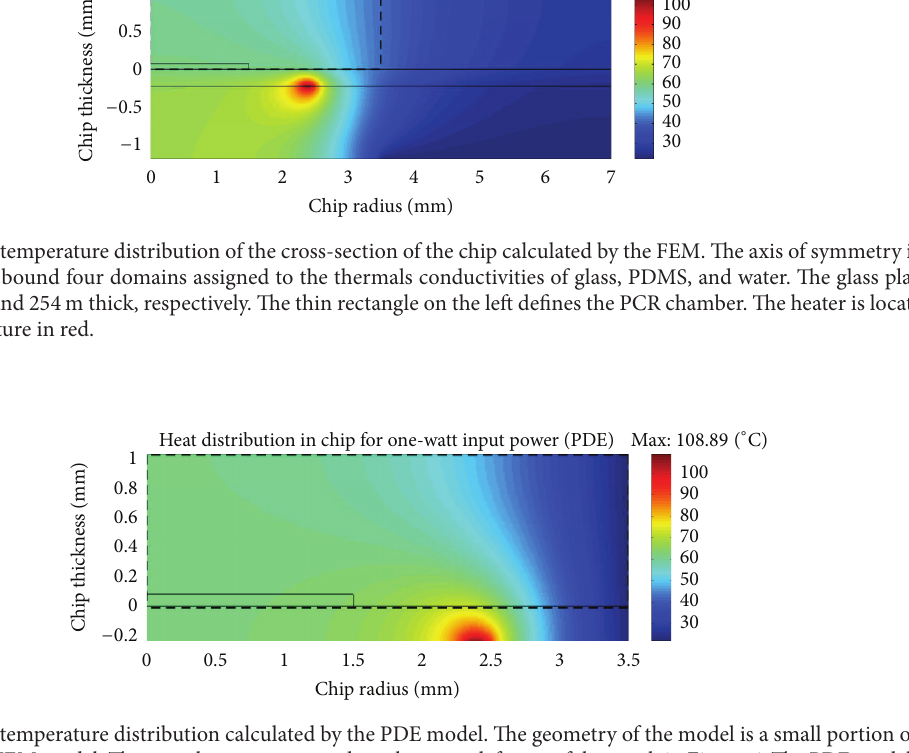
Figure 7: Steady-state temperature distribution calculated by the PDE model. The geometry of the model is a small portion of the geometry of real system and the FEM model. The area shown corresponds to the upper left part of the graph in Figure 6. The PDE model represents the system with a single material. The dashed lines indicate the location of the chamber and PDMS layer but do not define domains of different